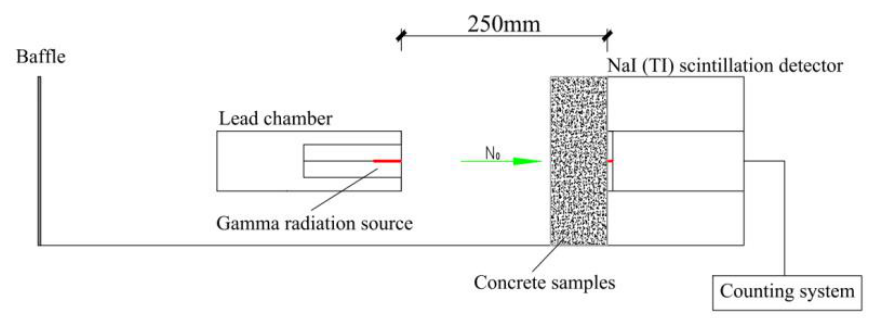
Figure 4. Gamma radiation shielding test diagram.